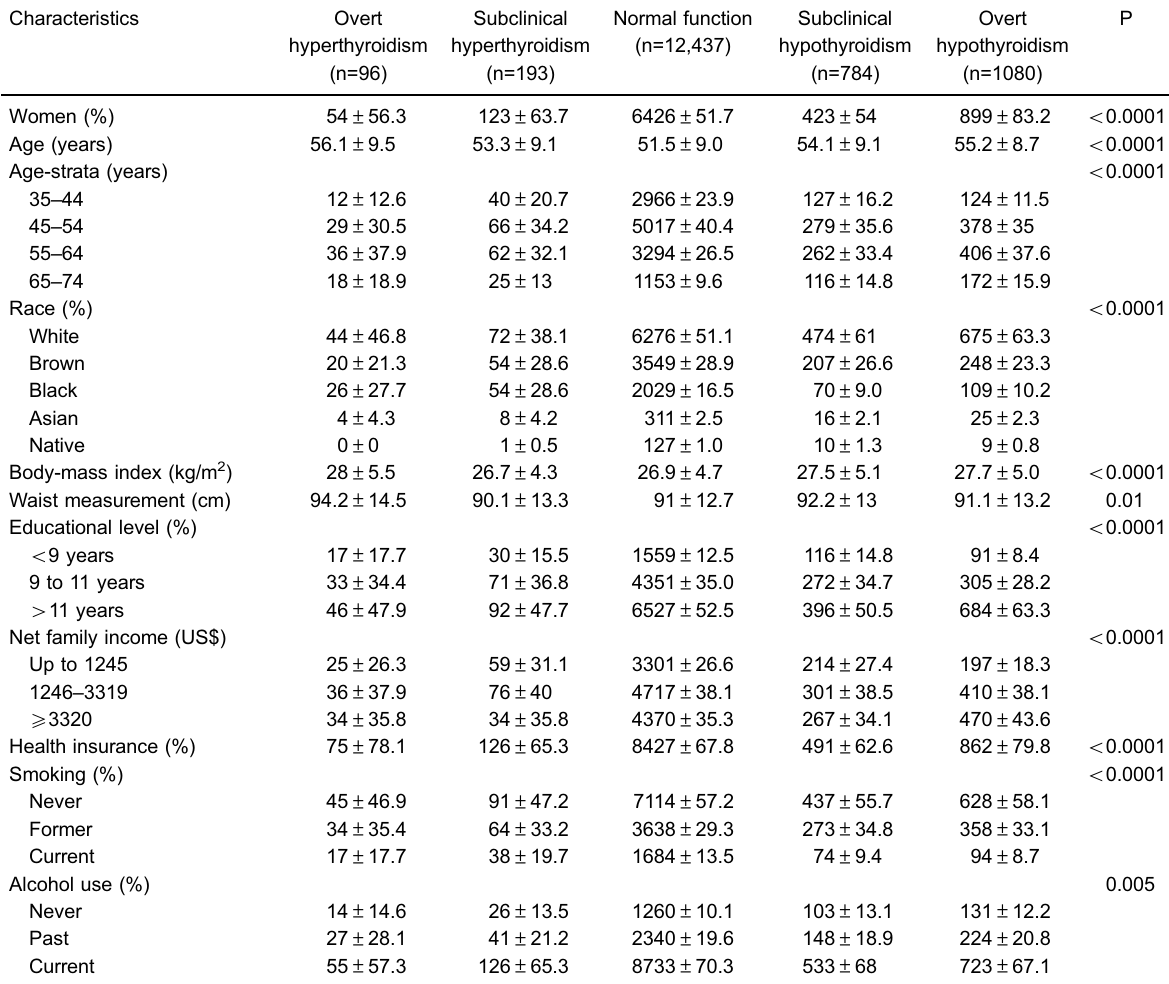
Table 1. Baseline characteristics of ELSA-Brasil participants according to thyroid function status.